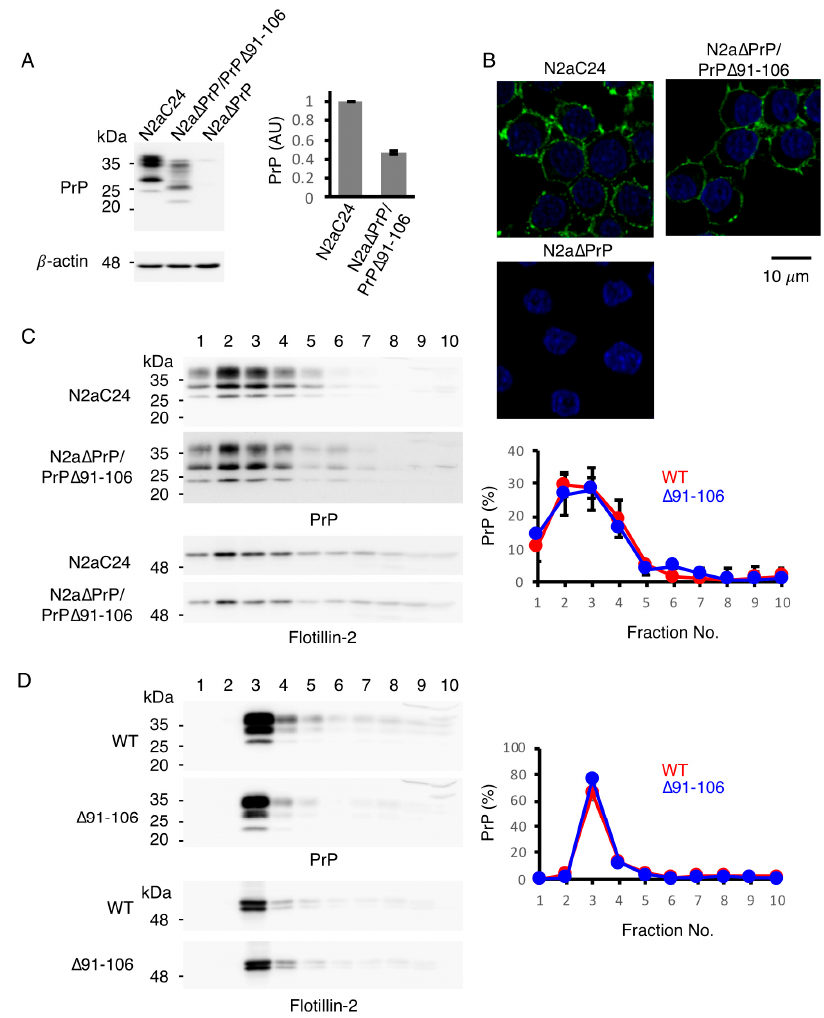
Figure 2. Subcellular localization of PrP ∆ 91–106 at raft micromembrane domains. ( A ) Left: Western blotting (15% SDS-PAG) of N2aC24, N2a ∆ PrP/PrP ∆ 91–106 and N2a ∆ PrP cells for WT PrP C and PrP ∆ 91–106 with IBL-N anti-PrP antibodies (40 μ g of total proteins). β -actin was used as an internal control (15 μ g of total proteins, 15% SDS-PAG). Right: Densitometric analysis of WT PrP C and PrP ∆ 91–106 in N2aC24 and N2a ∆ PrP/PrP ∆ 91–106 cells after normalization against β -actin. AU, arbitrary units. Data are presented as the mean ± SD of three independent experiments. ( B ) Immunofluorescence staining of WT PrP C and PrP ∆ 91–106 in permeabilized N2aC24, N2a ∆ PrP/PrP ∆ 91–106 and N2a ∆ PrP cells with SAF83 anti-PrP antibody. WT PrP C and PrP ∆ 91–106, green; nucleus, blue (DAPI staining). ( C ) Left: Western blotting of N2aC24 and N2a ∆ PrP/PrP ∆ 91–106 cells subjected to discontinuous sucrose gradient centrifugation for WT PrP C and PrP ∆ 91–106 with IBL-N anti-PrP antibodies (15% SDS-PAG) and a raft domain marker flotillin-2 (10% SDS-PAG). About 20% of each fraction were applied to western blotting. Right: Quantification of WT PrP C and PrP ∆ 91–106 in each fraction against the total WT PrP C and PrP ∆ 91–106. The signal density in each lane was evaluated against the total signal density of all lanes. Data are presented as the mean ± SD of three independent experiments. ( D ) Left: Western blotting of WT and Tg(PrP ∆ 91–106) / Prnp 0 / 0 mouse brains subjected to discontinuous sucrose gradient centrifugation for WT PrP C and PrP ∆ 91–106 with IBL-N anti-PrP antibodies (15% SDS-PAG) and flotillin-2 (10% SDS-PAG). About 3% of each fraction were applied to western blotting. Right: Quantification of WT PrP C and PrP ∆ 91–106 in each fraction against the total WT PrP C and PrP ∆ 91–106. The signal density in each lane was evaluated against the total signal density of all lanes. Data are presented as the mean ± SD of 3 independent